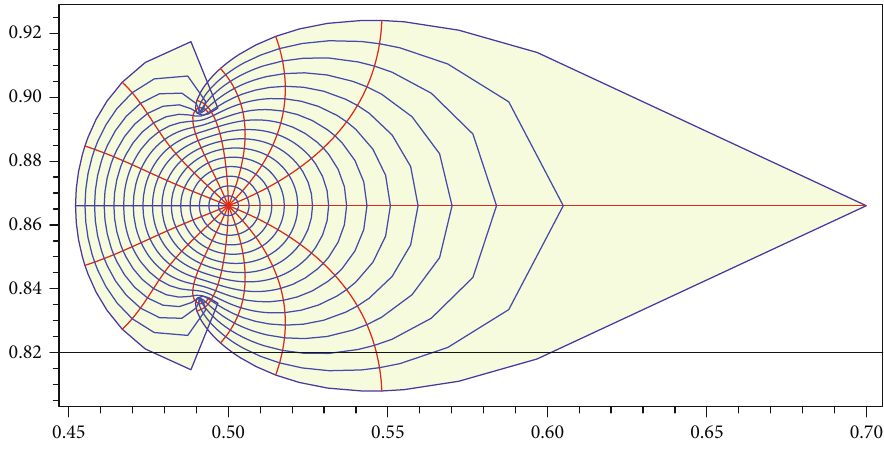
ξ Þ , if h ð ξ Þ = 1 + ξ /1 − ξ : σ ð